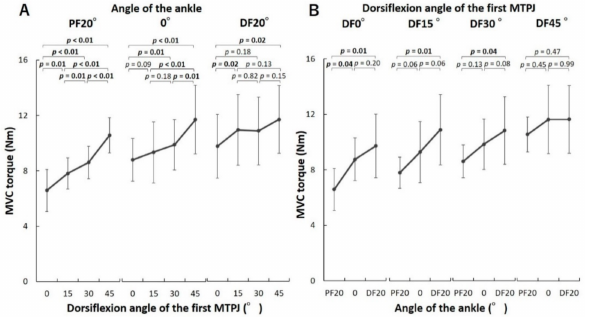
Figure 3. Comparison of the maximal voluntary contraction (MVC) torque of the first metatarsopha- langeal joint (MTPJ) at different MTPJ ( A ) and ankle positions ( B ). The torque-angle relationship corresponds to the ascending limb at dorsiflexed (DF) 0 ◦ –DF45 ◦ of the first MTPJ when the ankle was at plantar-flexed (PF) 20 ◦ and neutral (0 ◦ ), and the plateau region at DF15 ◦ –45 ◦ of the first MTPJ, when the ankle was at DF20 ◦